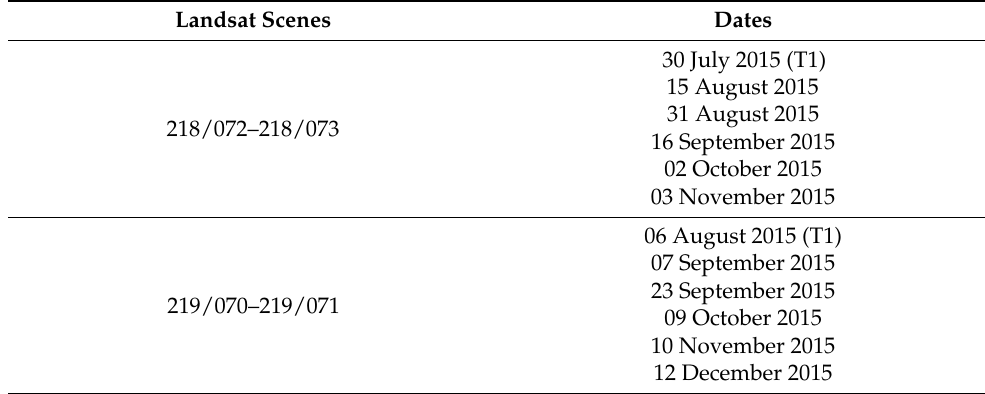
Table 1. Landsat scenes (path/row) and dates of the OLI images used in this study. T1 indicates the pre-fire image obtained for each Landsat